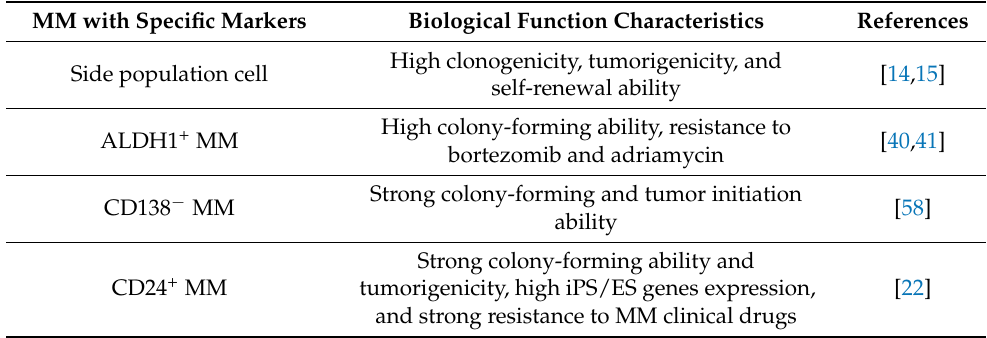
Table 3. Biological function characteristics of MM with specific